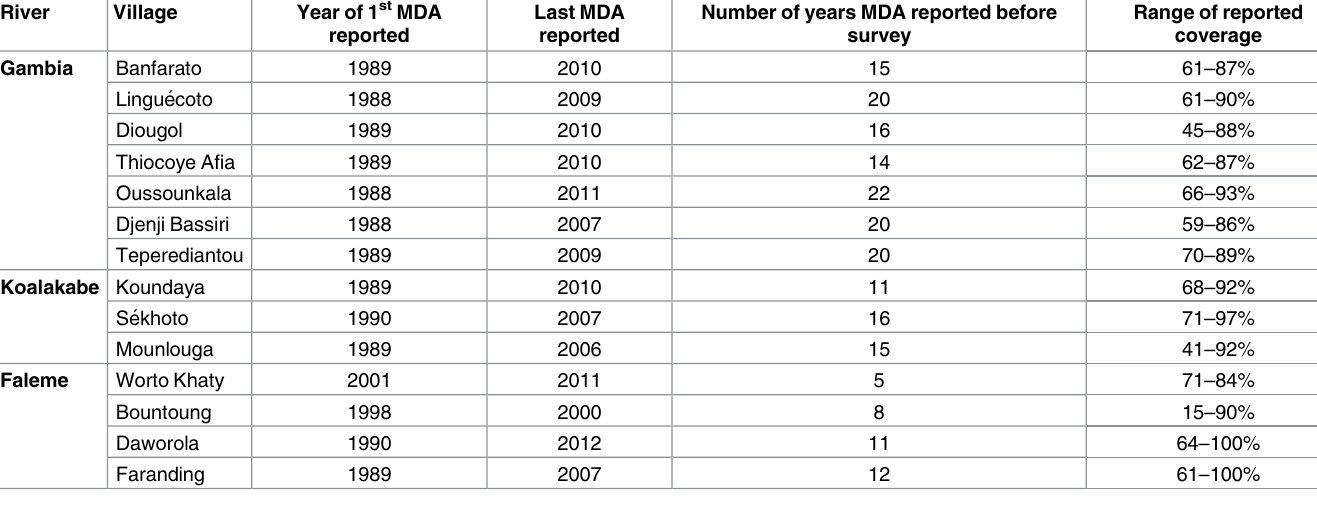
Table 1. Number of ivermectin mass drug administration round for onchocerciasis by river and village and reported coverage